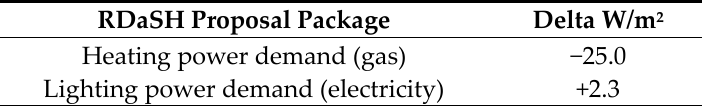
Table 2. Change in power demand density for an example upgrade proposal made by RDaSH [5] maintenance